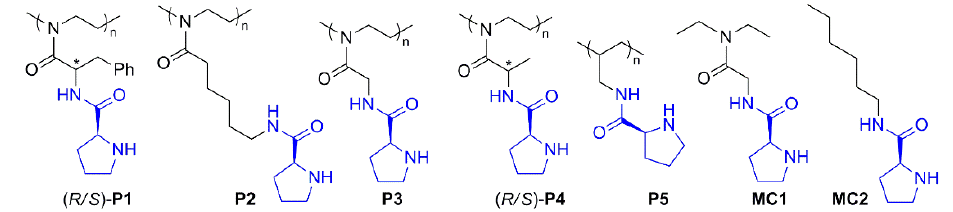
Figure 1. Structures of poly(2-oxazoline)-bound L-prolinamide catalysts ( P1 − P4 ), prolinamido- poly(allylamine) ( P5 ), and small-molecular analogs ( MC1 , MC2 ).